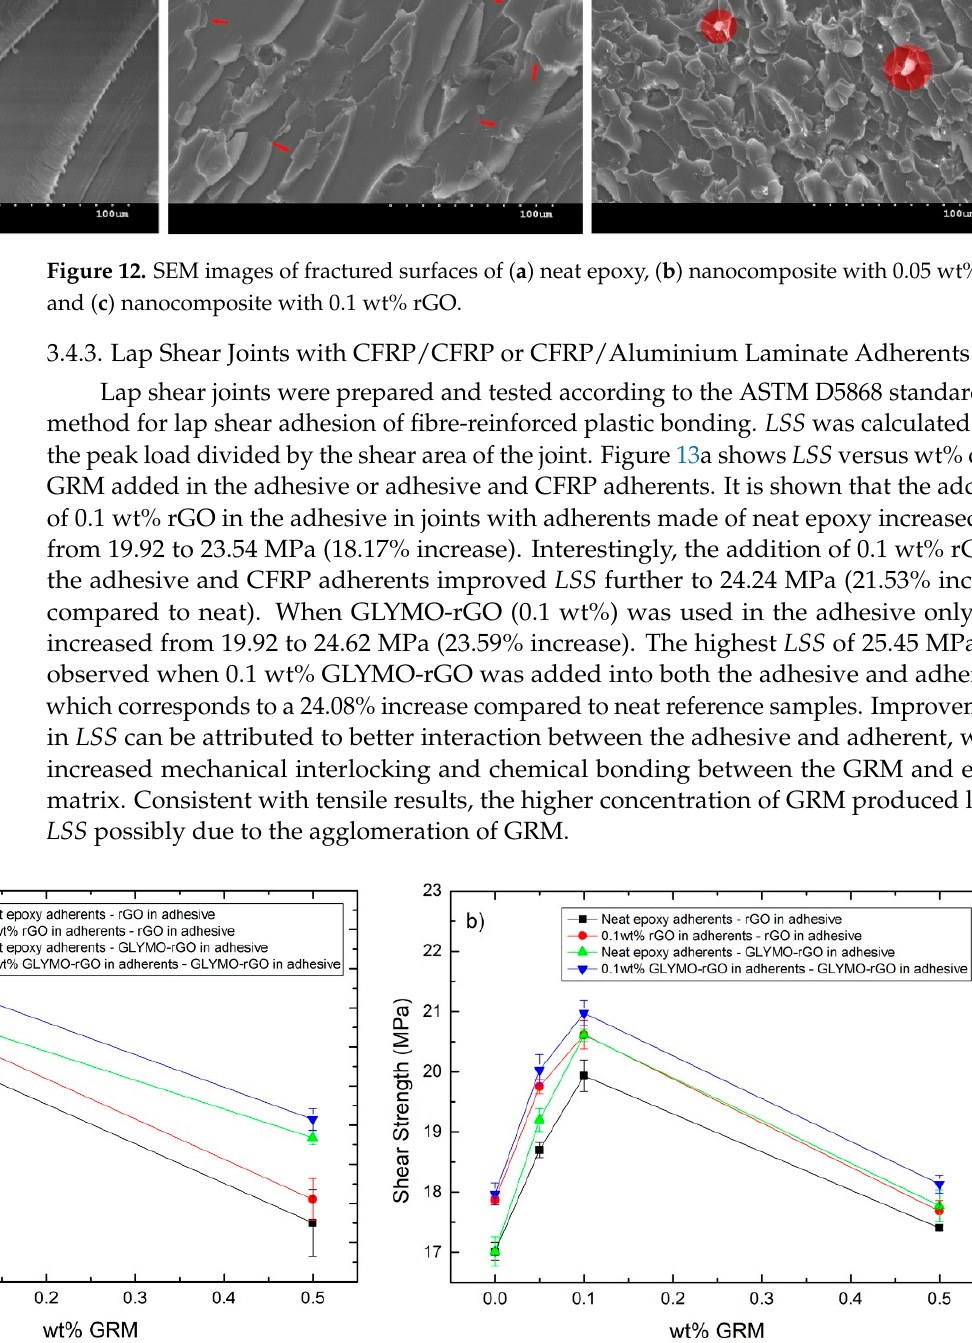
Figure 13. Lap shear strength versus wt% of GRM in adhesive for ( a ) CFRP/CFRP adherents and ( b ) CFRP/Aluminum adherents.